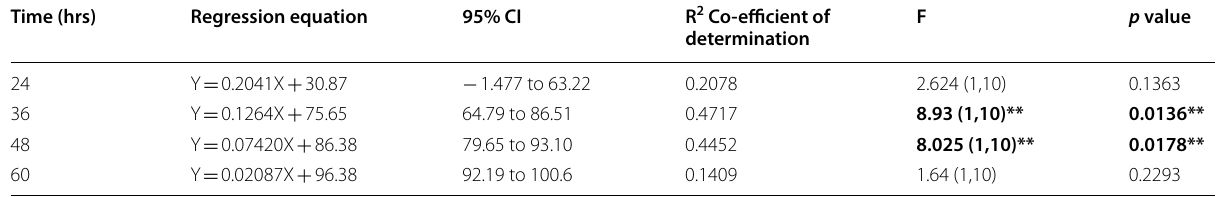
Bold values represent statistical significance ( p < 0.05)